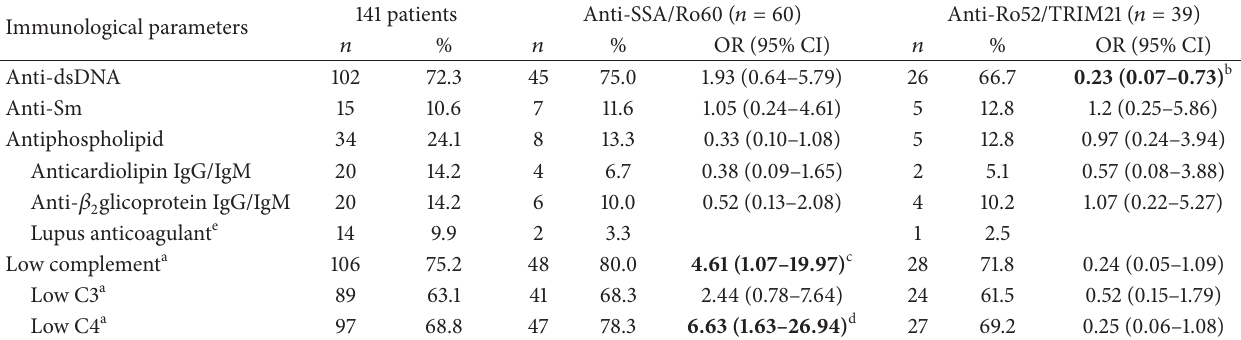
Table 3: Association of anti-SSA/Ro60 and anti-Ro52/TRIM21 with immunological parameters in SLE. Immunological parameters